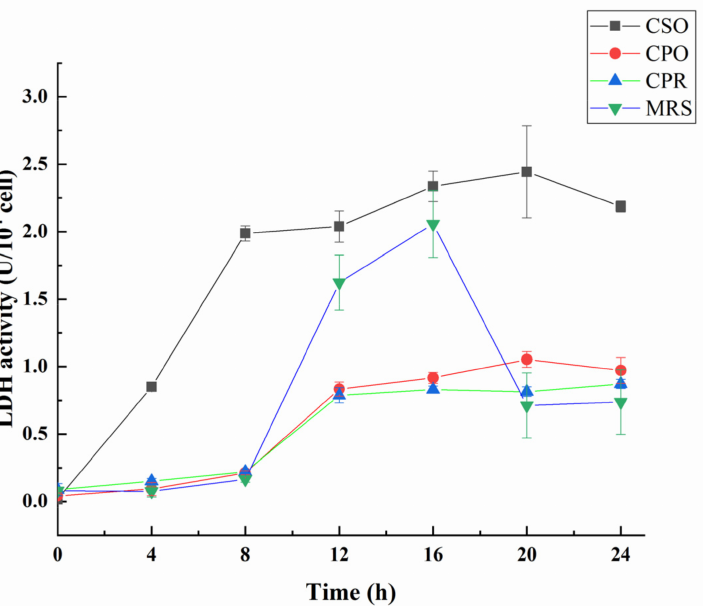
Figure 4. Effect of CSE on lactate dehydrogenase (LDH) activity during the growth of L. reuteri . Values are presented as mean ± standard deviation ( n =